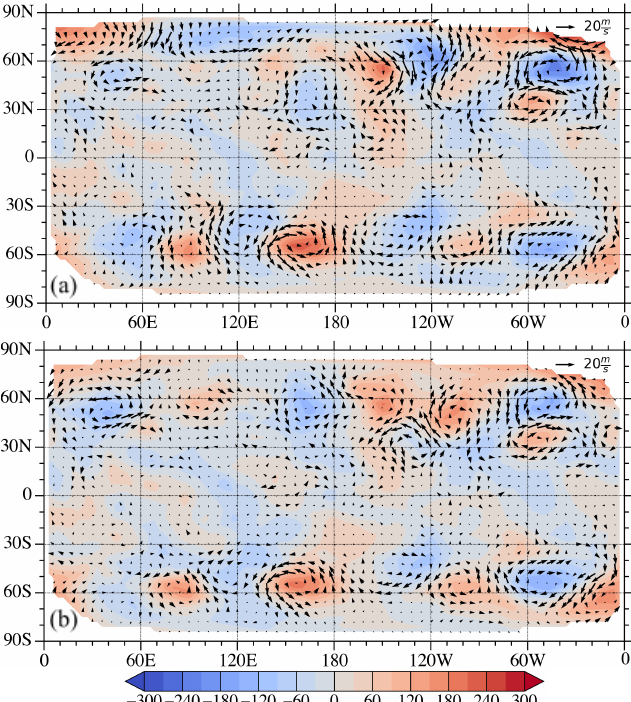
Figure 10. Differences in 5-day forecasts ( a ) between the control experiment and referenced high resolu- Fig. 10: Differences in 5-day forecasts (a) between the control experiment and referenced high tion simulations and ( b ) between the DA experiment and the referenced high-resolution resolution simulations and (b) between the DA experiment and the referenced high-resolution simulations.